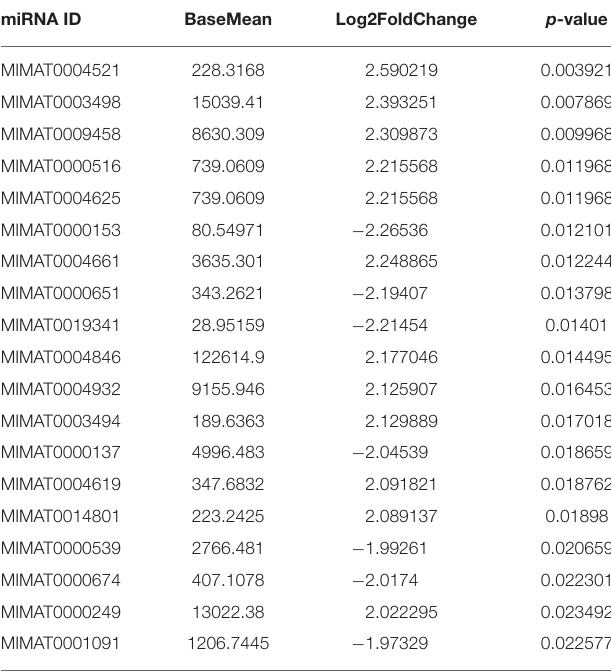
TABLE 2 | Differentially expressed miRNAs between 100 and 0 µ M DEHP treatment. miRNA ID BaseMean Log2FoldChange P -value